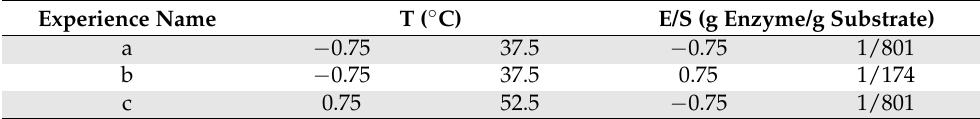
Table 2. DoE modeling experiments, coded and real